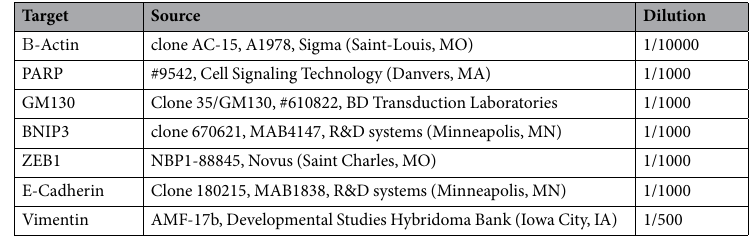
Table 1. List of antibodies used for this